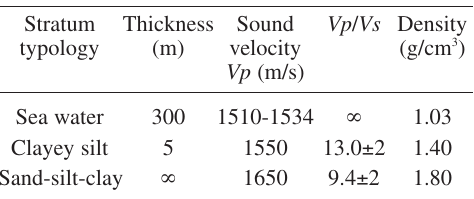
Table I. Physical values assigned to the propagation medium for the simulation: the medium is described according to a liquid layer (sea water) and two solid layers (clayey silt sediments above sand-silt-clay